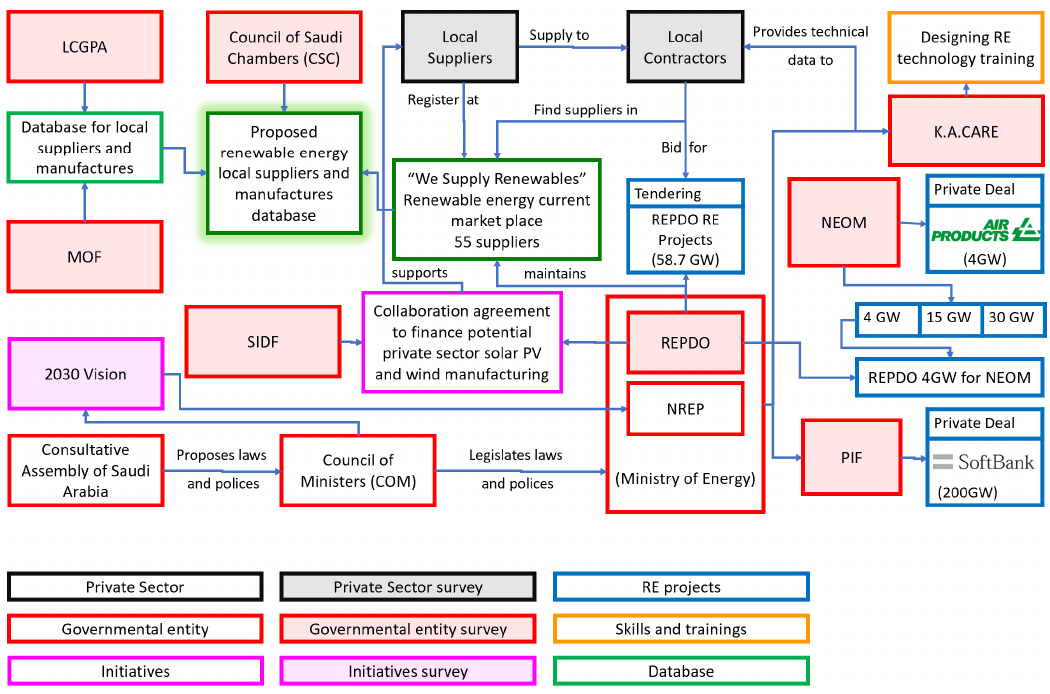
Figure 2. Renewable energy partnership and relationships to deliver Saudi Arabia renewable energy vision.